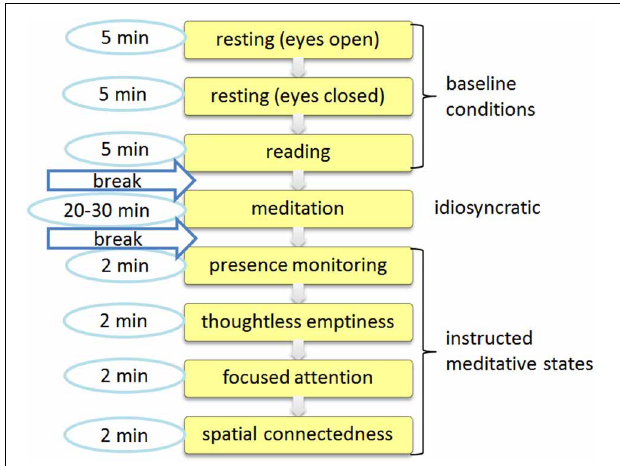
FIGURE 1 | Session protocol. The session consisted of an initial baseline recording that was followed by an idiosyncratic meditation task and a subsequent session with four specific meditative tasks.